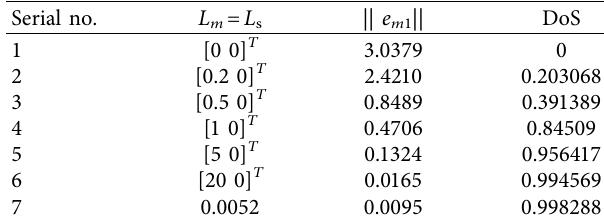
� L m s and fixed F